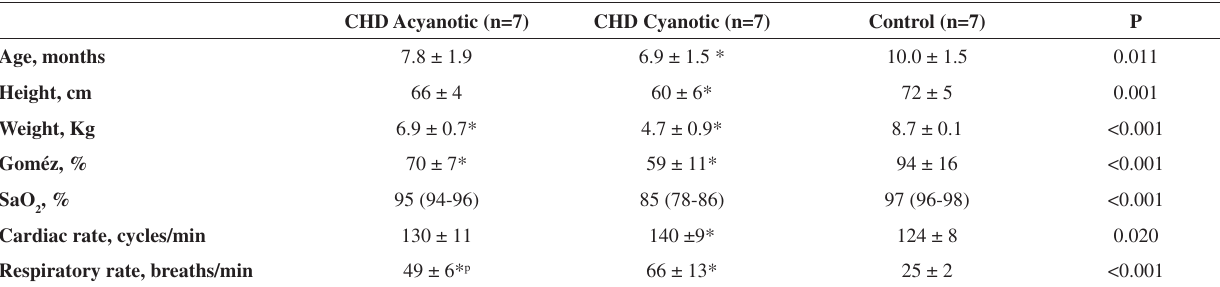
Table 2 - Demographic and physiological characteristics of the population studied. Data are presented as mean ± SD or median (25-75% inter-quartile